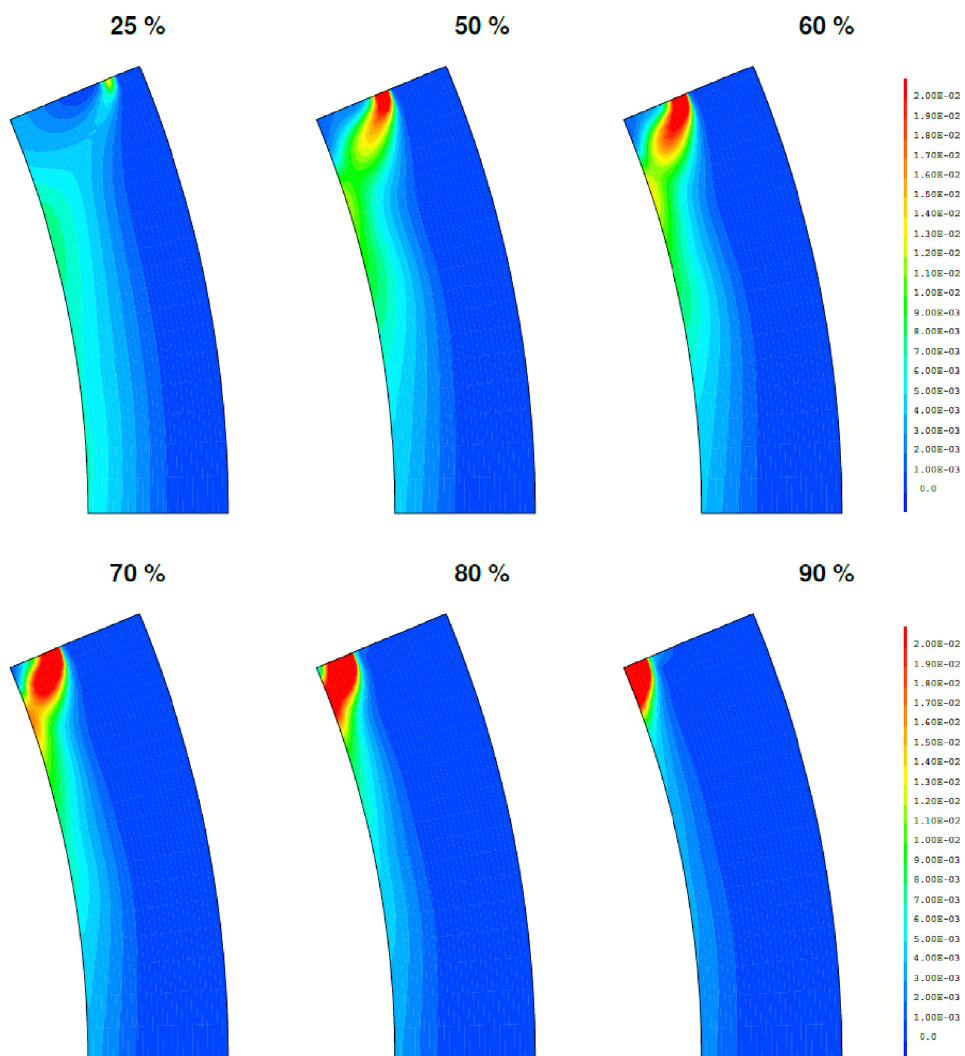
Fig. 6. Equivalent plastic strains calculated at the time of the REP-Na8 fuel rod loss of tightness in function of the hydride blister depth (in % of the clad wall